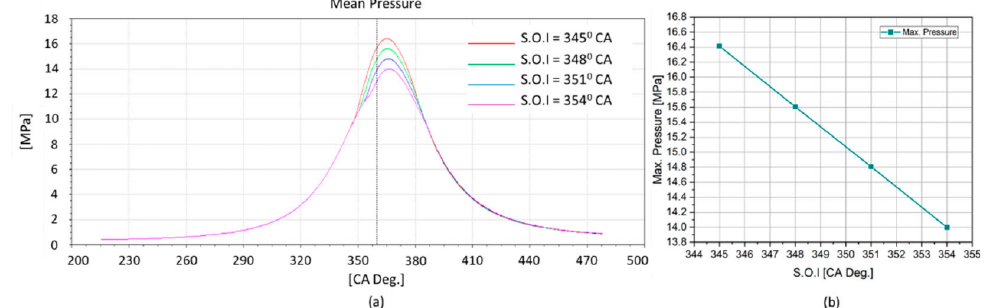
Figure 19. In-cylinder pressure diagrams ( a ) and maximum pressure ( b ) according to the change of the S.O.I angle in the diesel